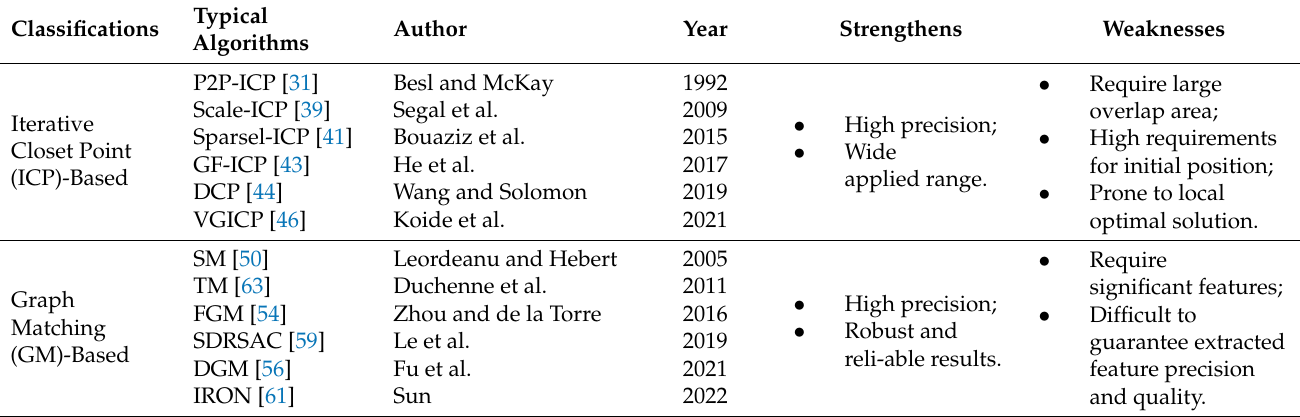
Table 1. Summary of registration algorithms based on hierarchical optimization.